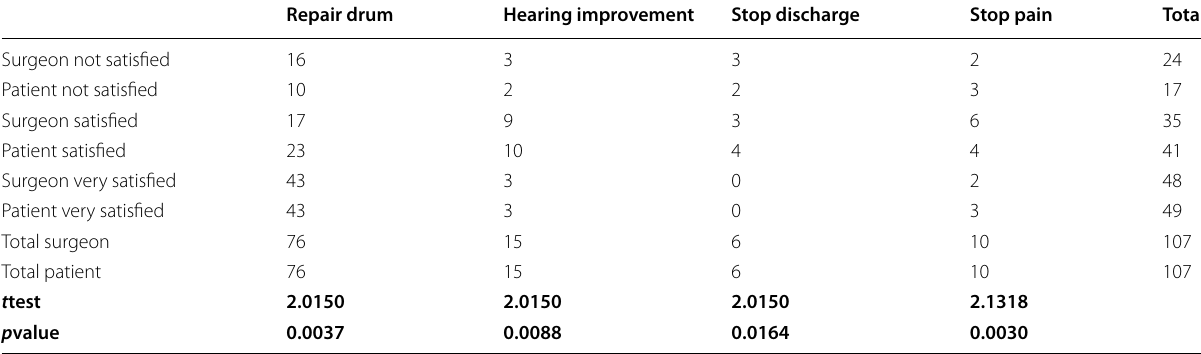
Table 4 Results on satisfaction patient/surgeon